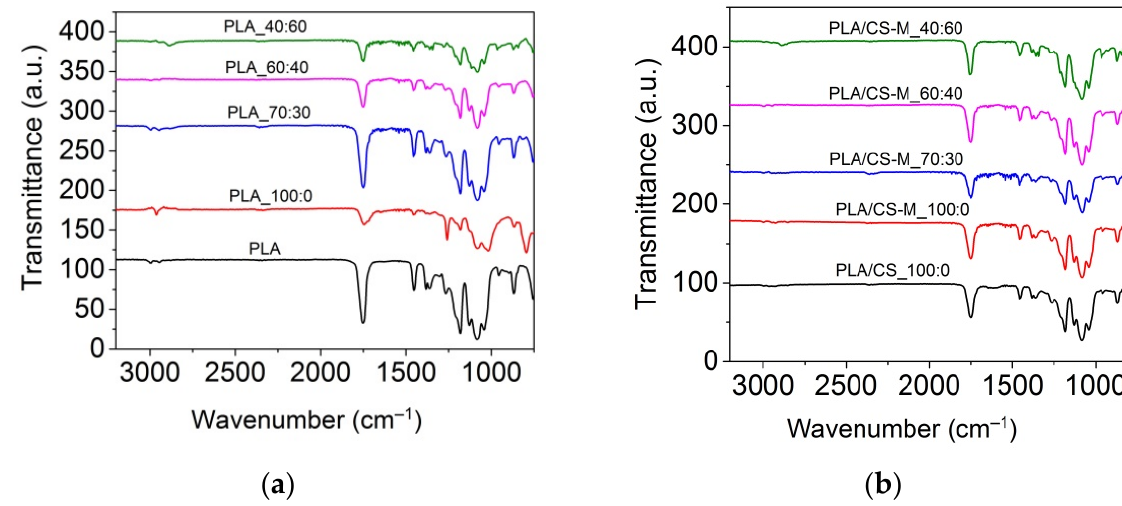
Figure 3. ATR-FT-IR spectra for PLA with MB and PEG bio-plasticizers ( a ), and PLA-based plasticized composites containing MB and PEG bio-plasticizers in different ratios, CS-M and vitamin E ( b ) in the 3200–750 cm − 1 spectral range.